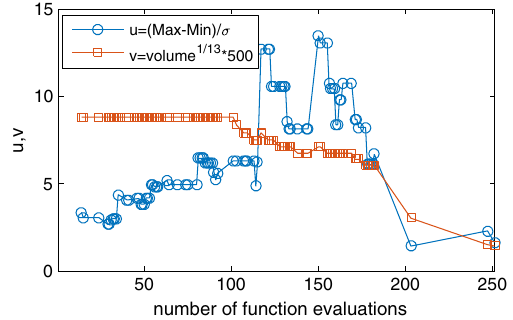
FIG. 4. Evolution of the simplex size as indicated by the u (circles) and v (squares) parameters defined in Eq. (4) during the RSimplex optimization run for the coupling correction experi- ment.